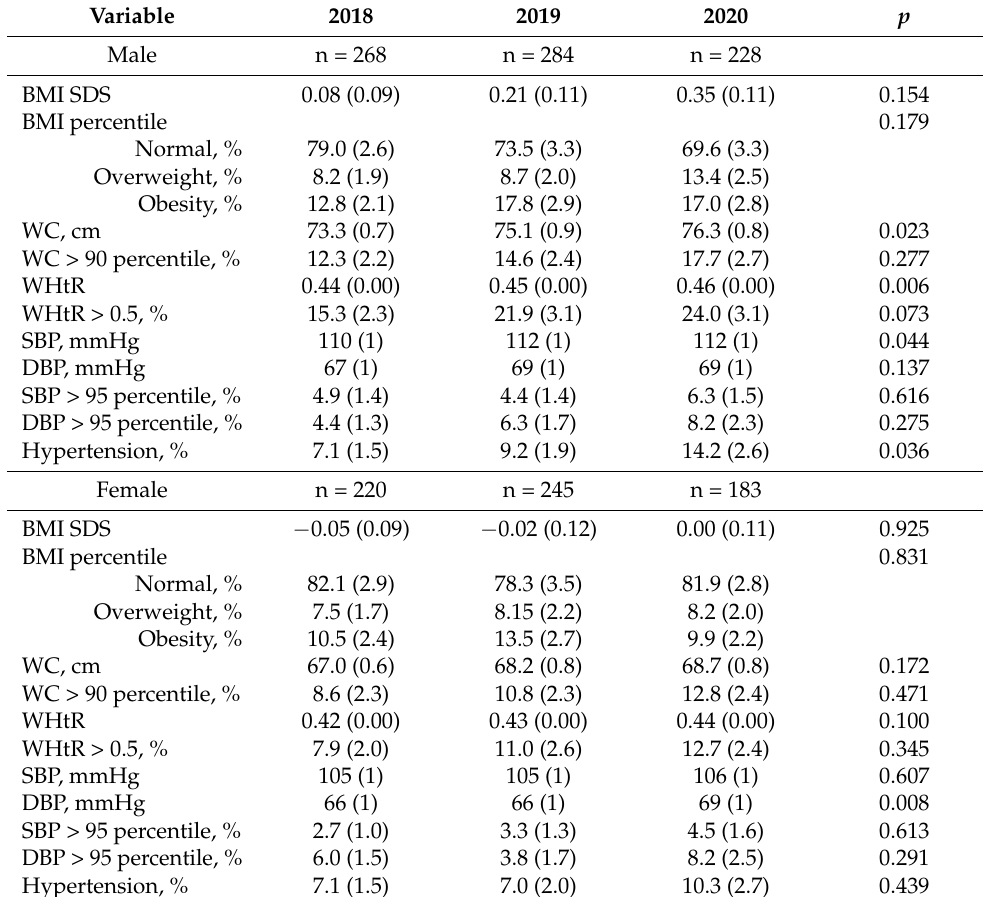
Table 2. Proportion of participants with obesity, abdominal obesity, and hypertension according to